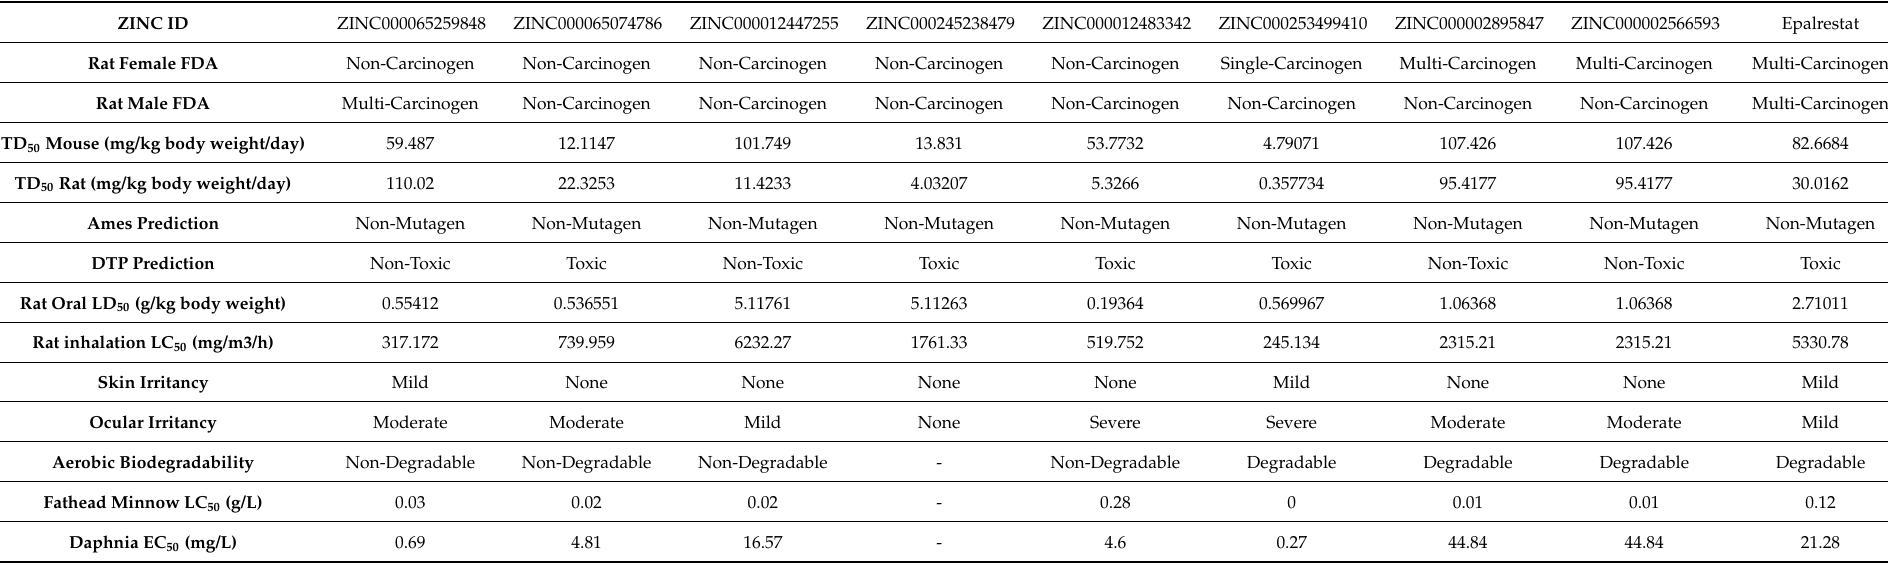
Table 5. Toxicity evaluation of the best-filtered